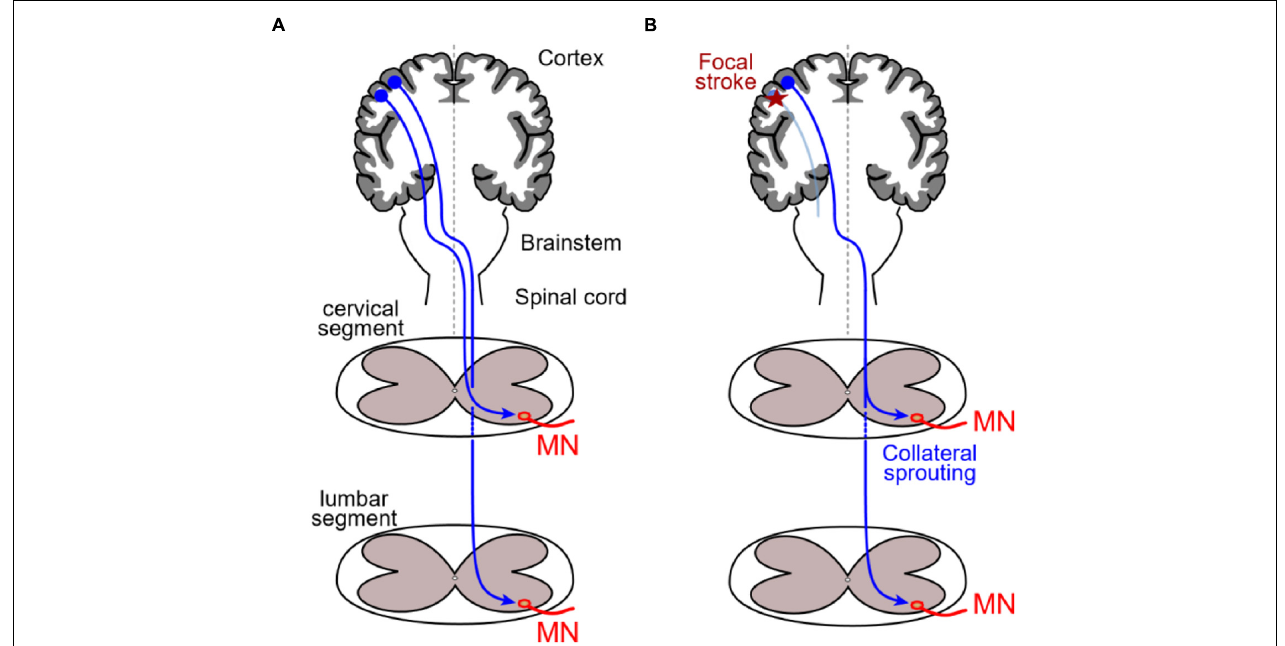
FIGURE 2 | Unilateral stroke-evoked corticospinal plasticity. (A) In normal rats, corticospinal neurons from sensory-motor areas (dark blue projections) specifically connect either cervical or lumbar spinal MNs respectively involved in fore- and hindlimb fine motricity. (B) After a focal stroke in the cortical region hosting neurons projecting into cervical segments (red star), forelimb-related corticospinal neurons degenerate (light blue), and hindlimb-related neurons normally projecting only onto lumbar MNs sprout collaterals that make synapse onto cervical MNs deprived of their normal corticospinal inputs.